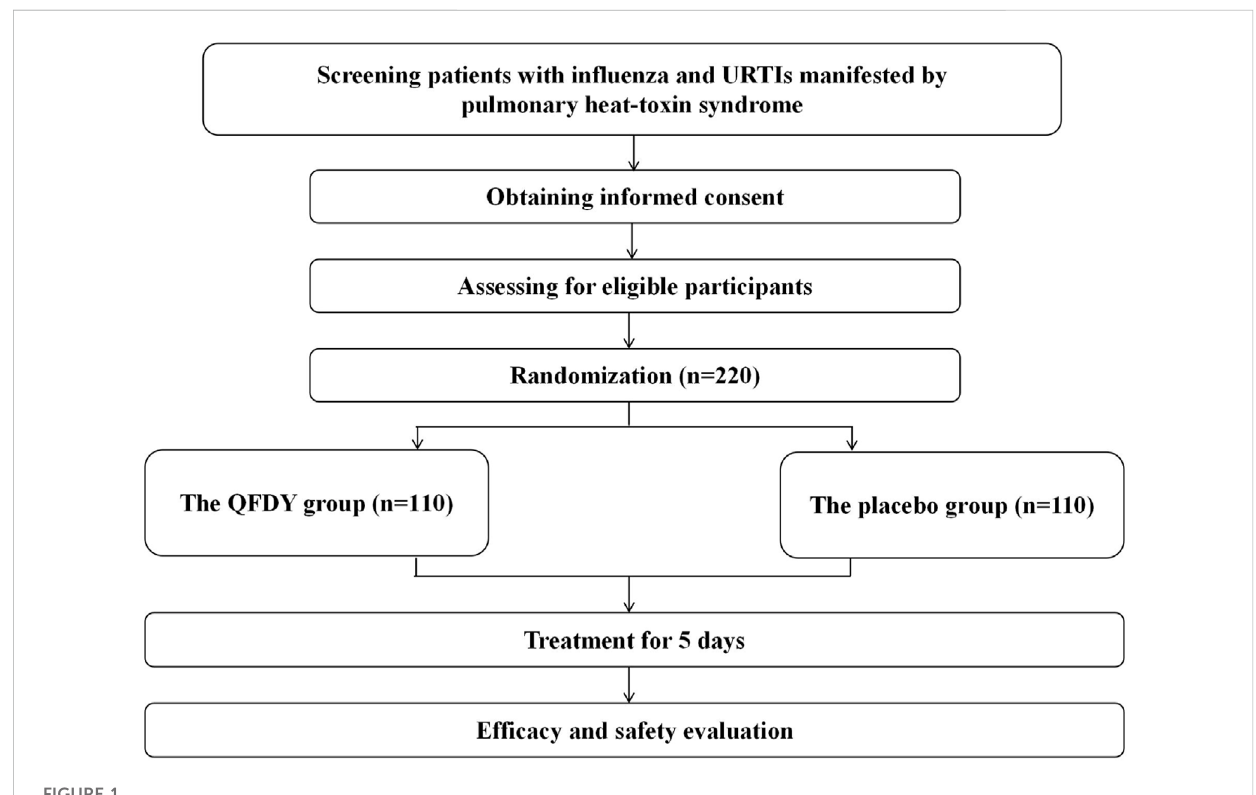
FIGURE 1 Flow diagram of the